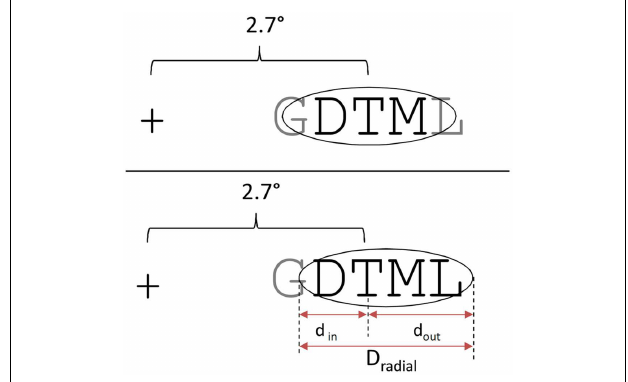
FIGURE 7 | Crowding zone determined by Bouma’s law without inward-outward asymmetry (upper panel) and with inward-outward asymmetry (bottom panel), following the model proposed by Nandy andTjan (2012). This demonstrates that the inward-outward asymmetry enables a complete non-adjacent letter to fall in the crowding zone in the four-flanker condition of the present